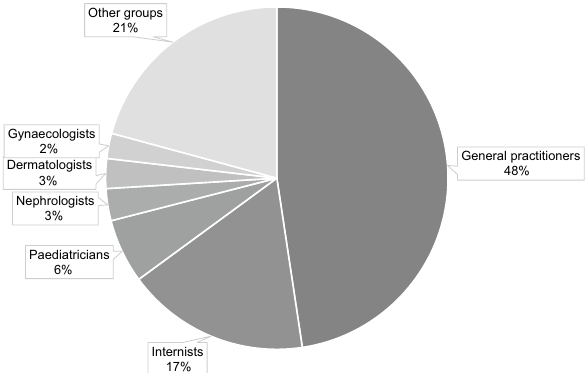
Figure 2. Distribution of Alerting letters (ALs) to specialist groups. Most ALs were issued to general practitioners, followed by internists while paediatricians, nephrologists, dermatologists and gynaecologists contributed